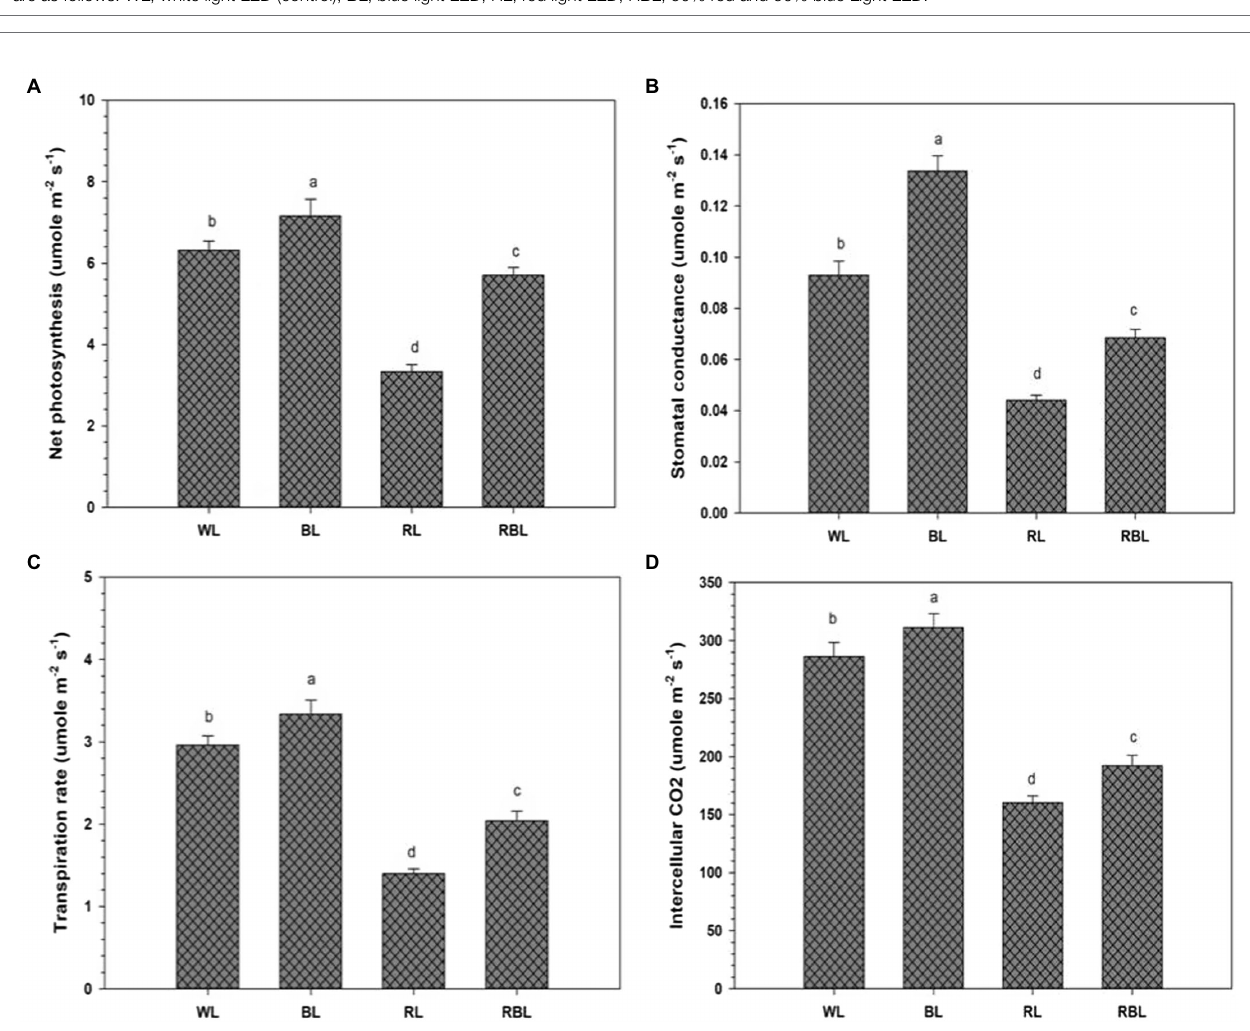
FIGURE 1 | Effects of differential light quality on SPAD (Soil Plant Analysis Development) value of industrial hemp grown under different color light-emitting diodes. Bars indicated the mean ± SD ( n = 3). Different letters on bars indicated significant difference between treatments at p ≤ 0.05. Different abbreviations used in the figure are as follows: WL, white light LED (control); BL, blue light LED, RL, red light LED; RBL, 50% red and 50% blue Light LED.